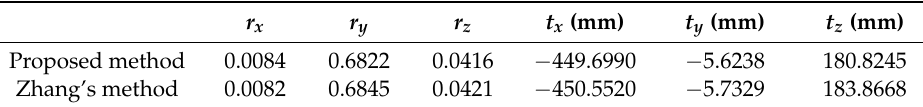
Table 2. Comparison of the extrinsic parameters.